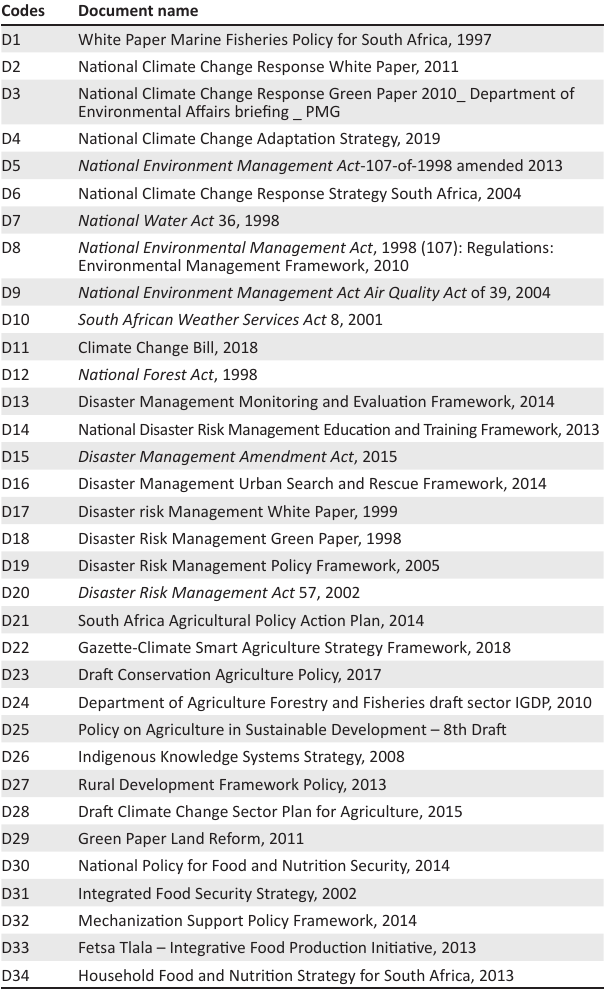
TABLE 1: List of climate change adaptation, disaster risk reduction and food security documents in South Africa